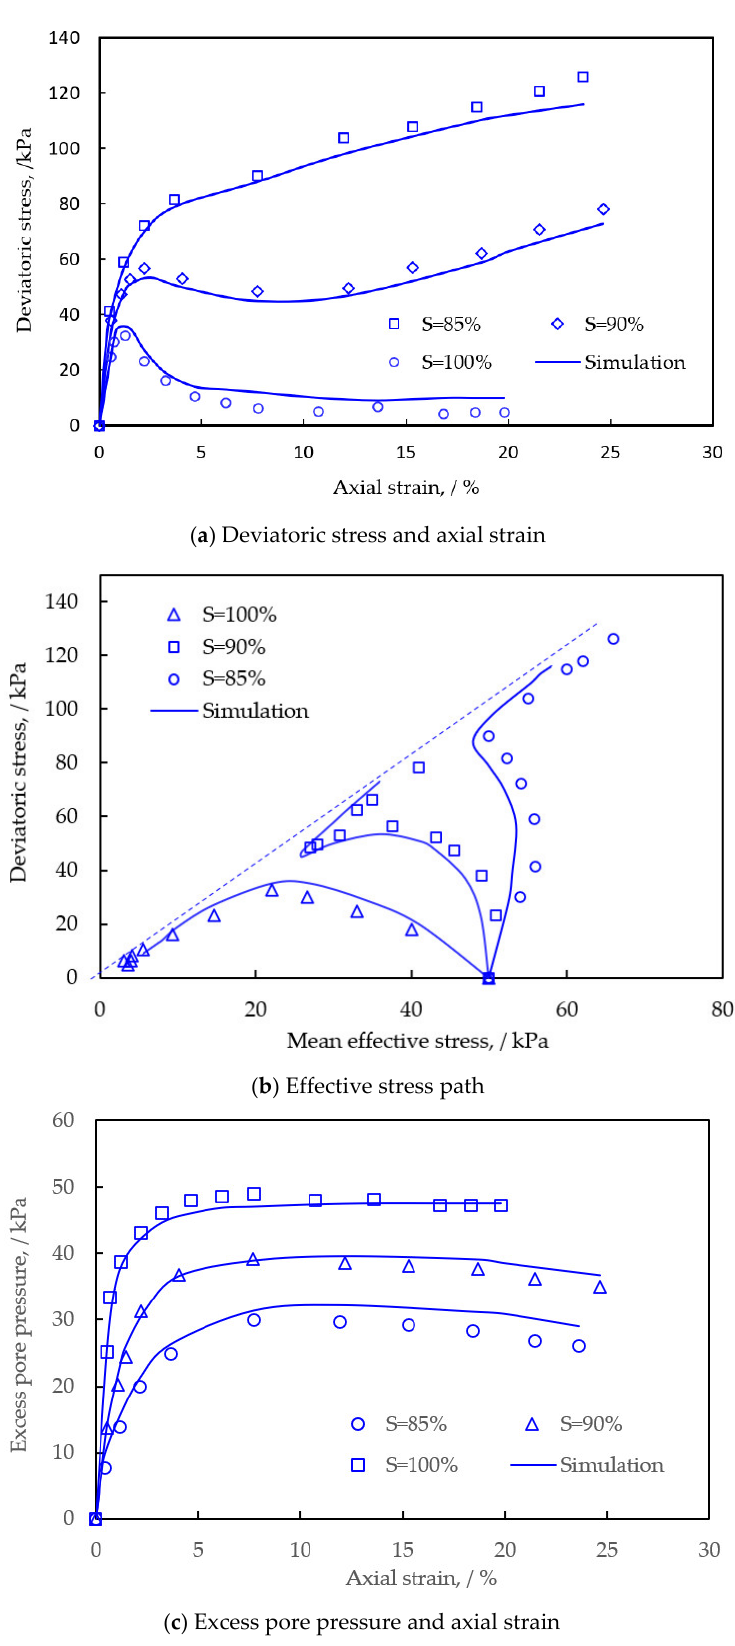
Figure 4. Undrained triaxial compression test results and model simulations for gassy sand ( e 0 = 1.09, p c = 50 kPa).